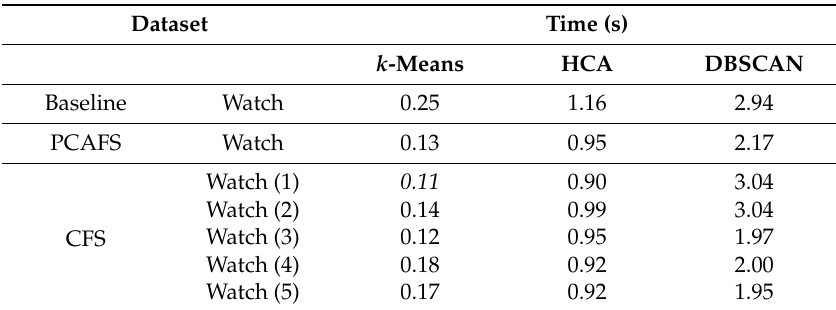
Table 6. Processing time of clustering the Watch data. The bold and italic value denotes the fastest overall time that has been